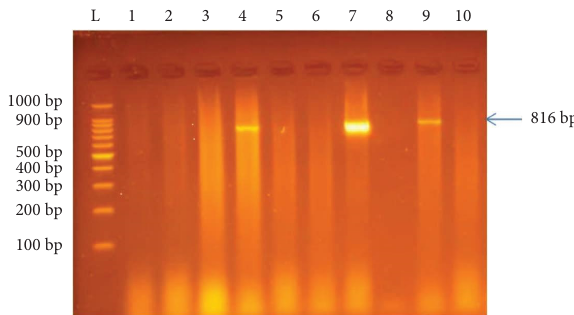
Figure 2: Representative PCR amplicons of Campylobacter